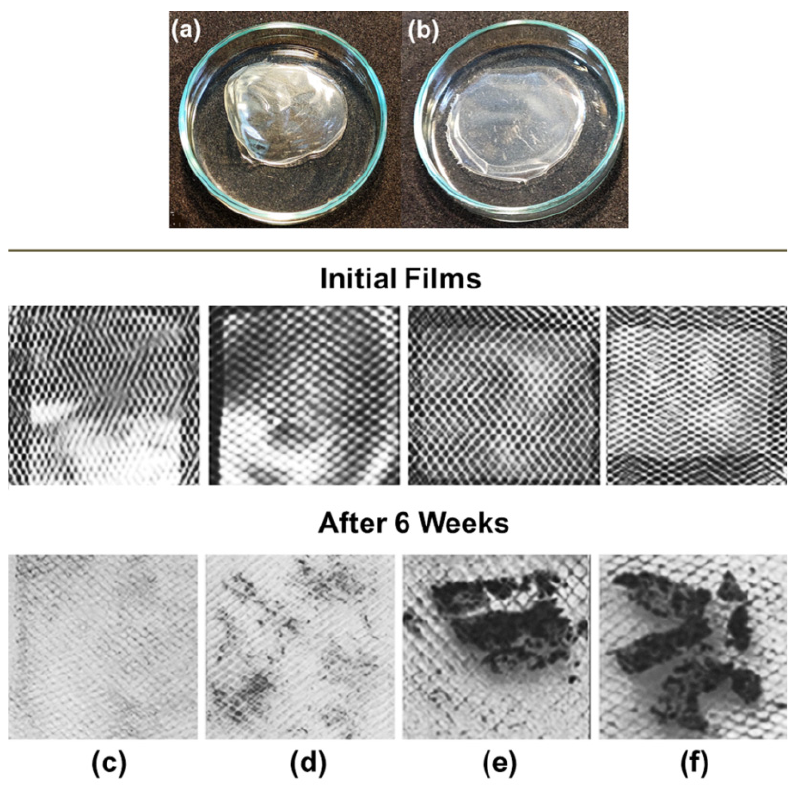
Figure 8. Images of films from ( a ) ALG and ( b ) anionic IPEC with Q 2 = [QHECE]/[ALG] = 0.1. Cups with the initial film samples and the samples taken out of the cups after 6 weeks of being buried in soil: ( c ) ALG, ( d ) QHECE, ( e ) anionic complex with Q 2 = [QHECE]/[ALG] = 0.1, ( f ) cationic complex with Q 1 = [ALG]/[QHECE] = 0.2.